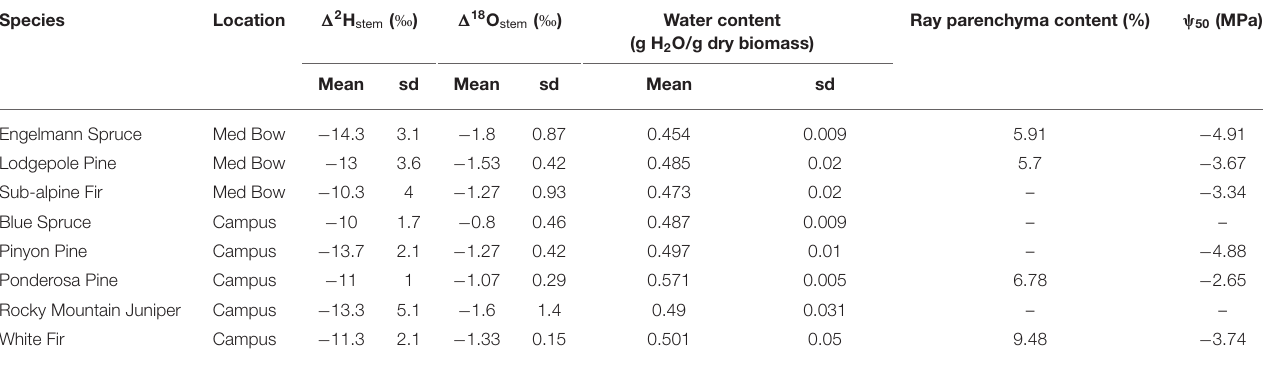
TABLE 2 | Summary statistics of 1 2 H stem , 1 18 O stem , water content values as well as values of ray parenchyma content (RP) and ψ 50 from literature for each species (see wood metrics section of methods for literature sources).